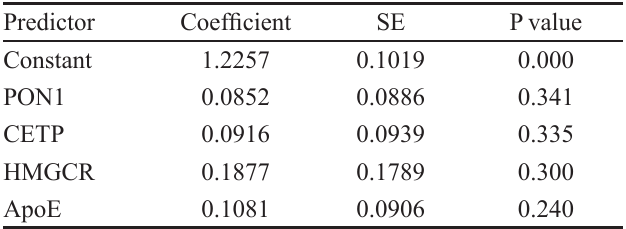
TABLE V - Coefficients of the linear models adjusted to MDA